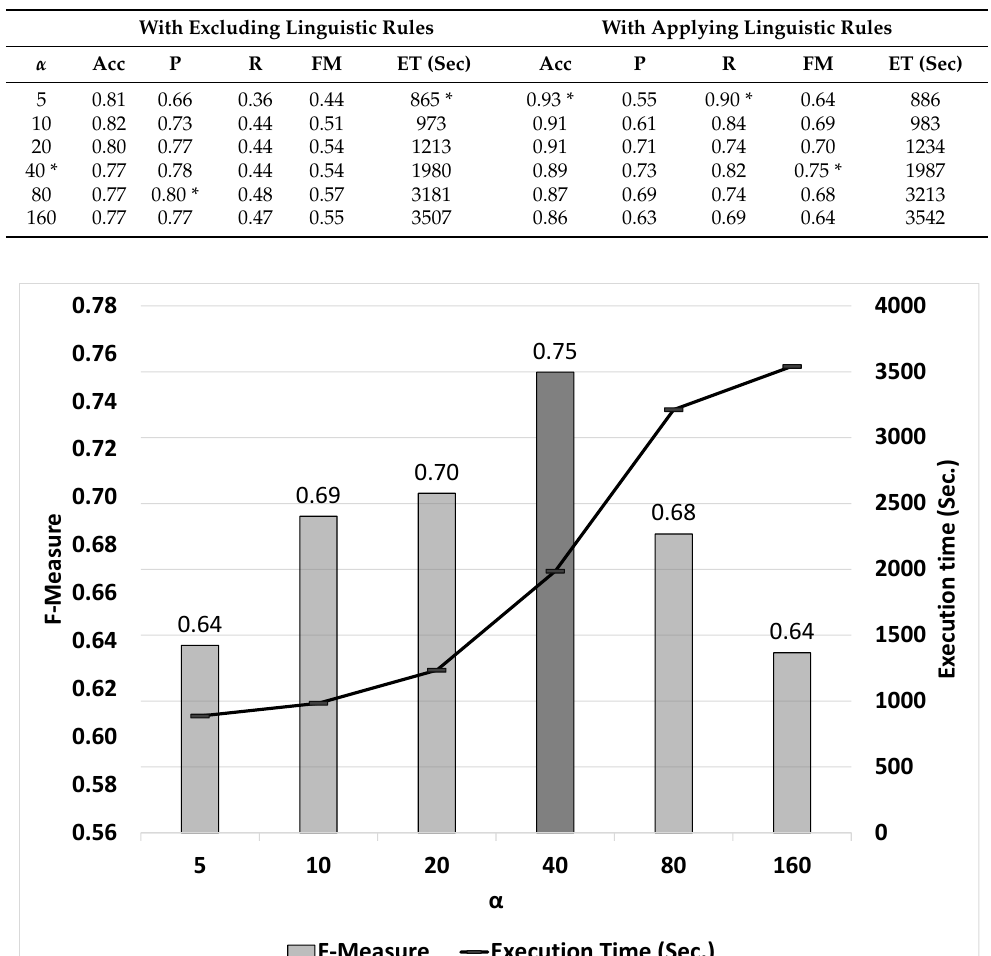
Table 5. Ablation study of our PDTS to assess the effectiveness of applying our linguistic rules, described in Table 2. The base model is mBERT and θ = 0.4. The best performance found is indicated by the asterisk *.